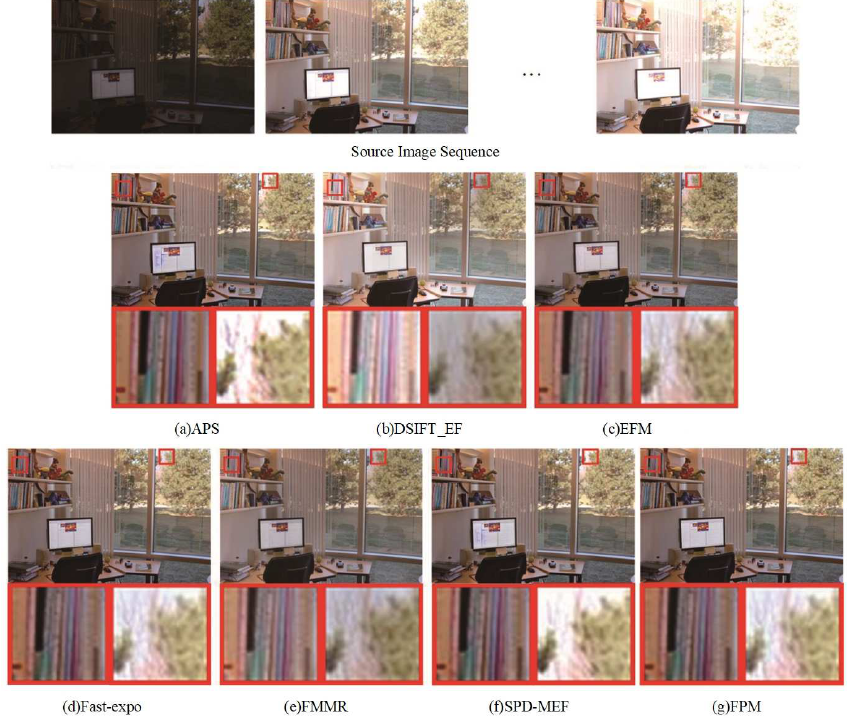
Figure 5. Comparison of the “Office” fusion images obtained by the seven fusion methods. ( a )